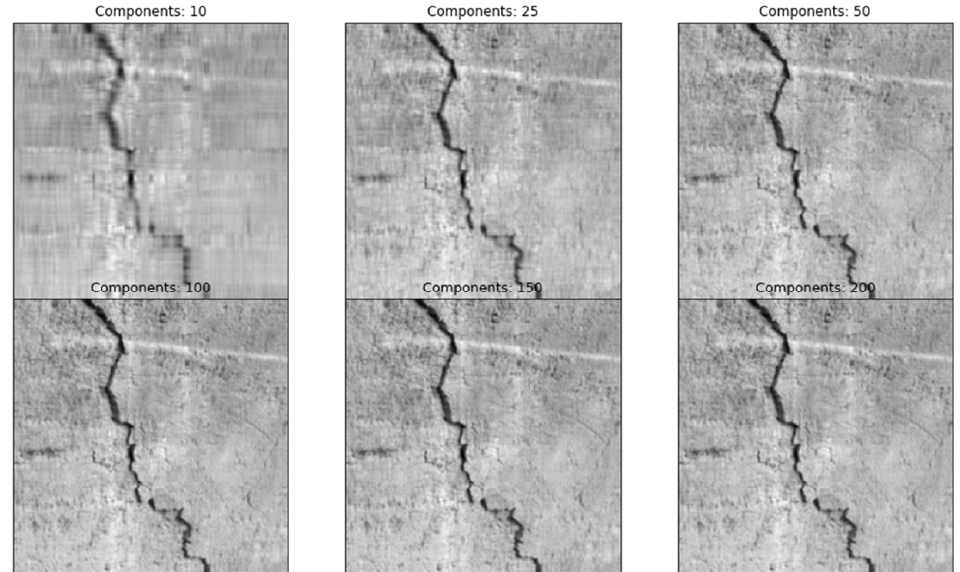
Figure 3. Example of image reconstruction after KPCA application with different numbers of components (original RGB image taken from [25]).